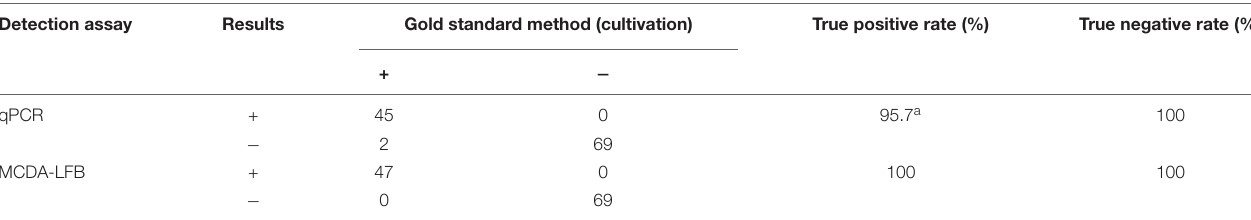
TABLE 3 | Conventional cultivation, quantitative polymerase chain reaction (qPCR), and multiple cross displacement amplification-lateral flow biosensor (MCDA-LFB) comparisons for N. gonorrhoeae testing in clinical samples. Detection assay Results Gold standard method